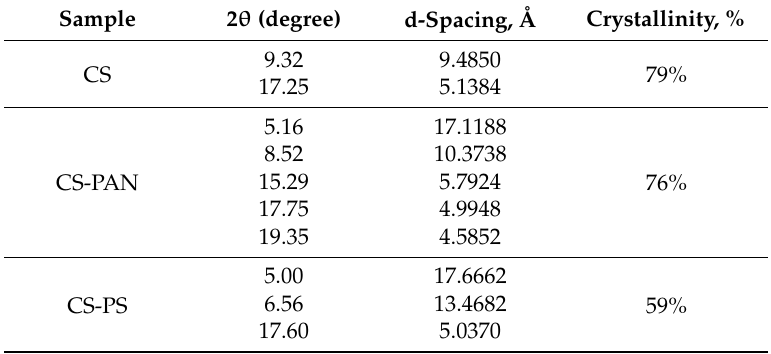
Table 2. Values of d-spacing and crystallinity calculated from the XRD